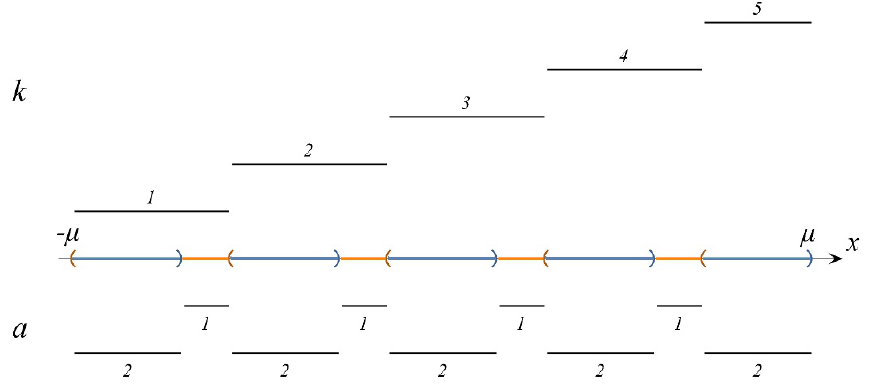
Figure 1 . Integers k and a that characterize the Green’s function of the di(cid:11)erence equation. The interval ( (cid:0) (cid:22); (cid:22) ) splits in two types of subintervals with a = 2 and a =